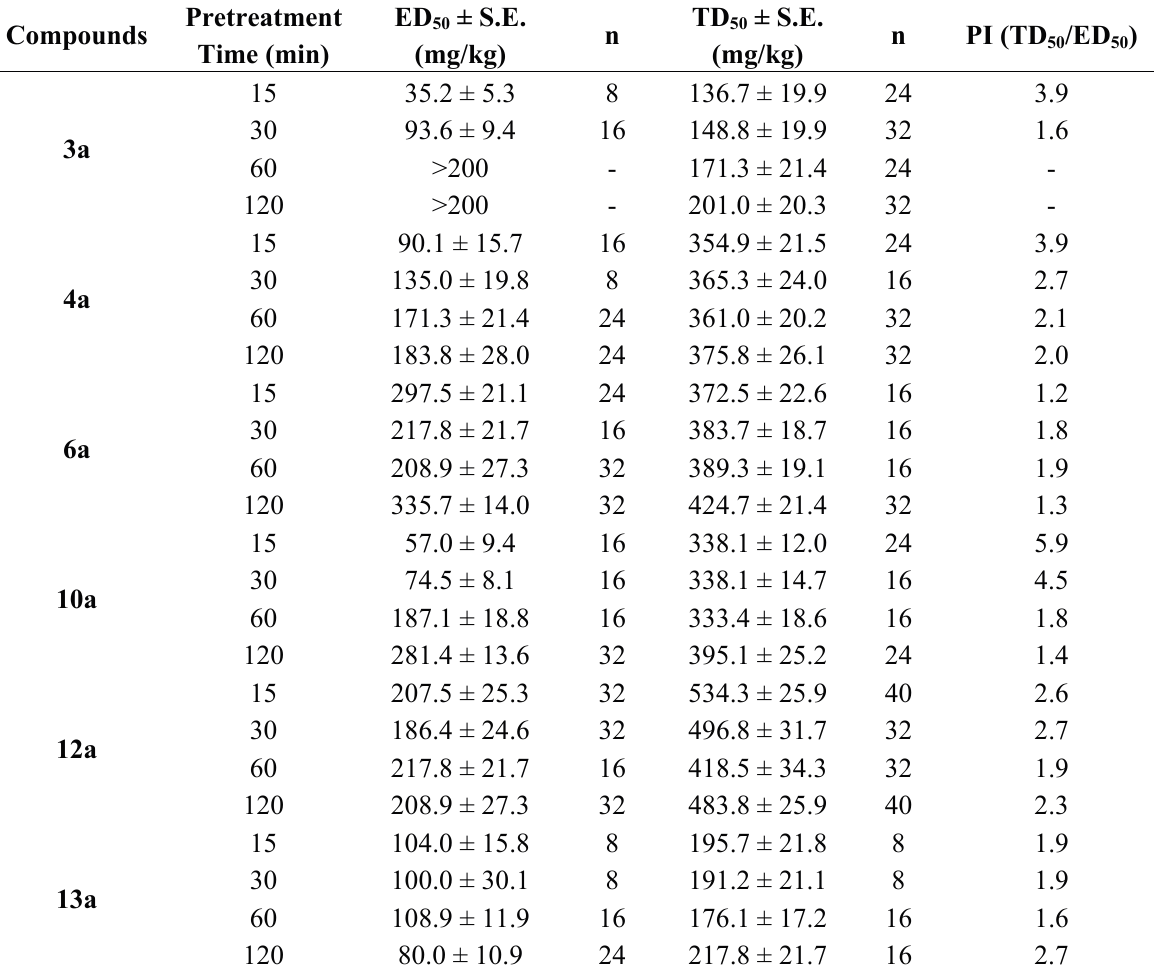
Table 2. Time-course and dose-response effects of the active compounds in the MES and chimney tests in mice. Results are presented as median effective doses (ED median toxic doses (TD ± S.E.) of the examined compounds. All compounds were 50 administered i.p. , at four various pretreatment times (15, 30, 60, 120 min.) prior to the appropriate pharmacological test (MES or chimney test). n - the total number of animals used at those doses whose anticonvulsant/toxic effects ranged between 4 and 6 probits.